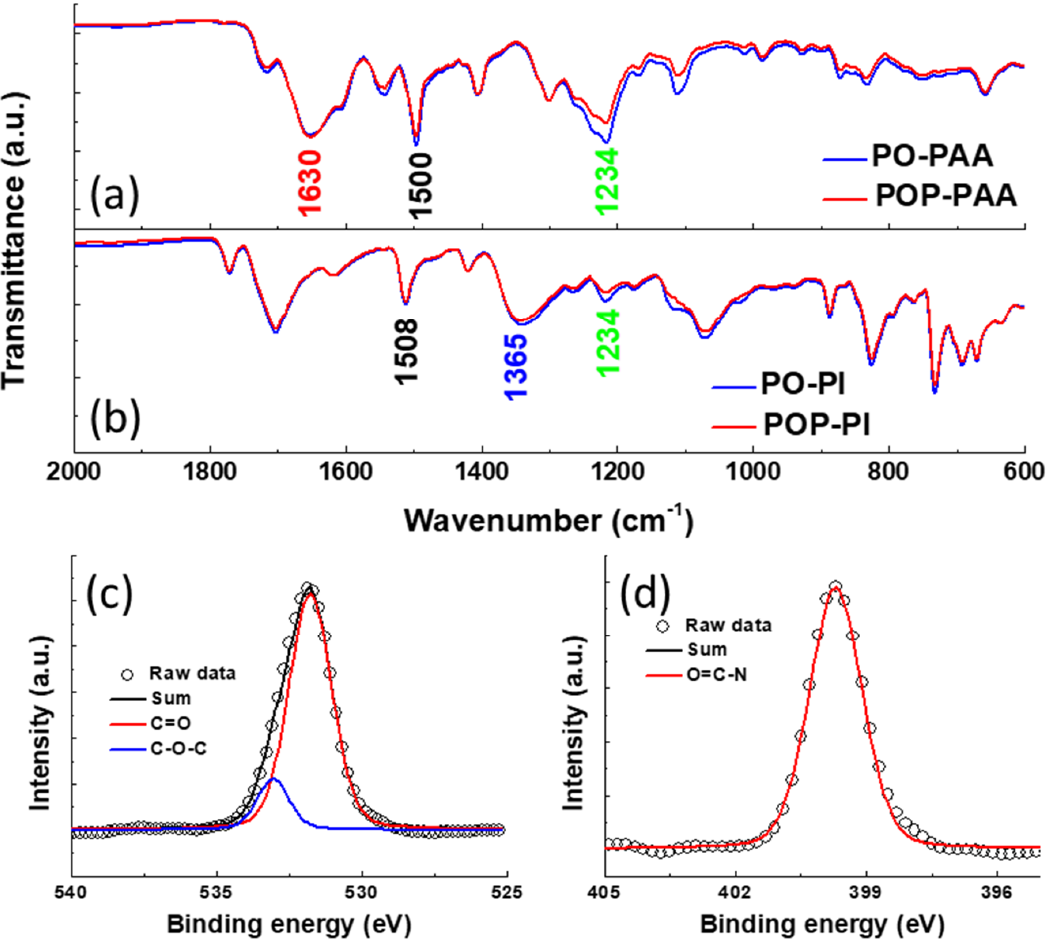
Figure 2. The Fourier transform infrared (FTIR) spectra of ( a ) PO-PAA and POP-PAA and ( b ) PO-PI and POP-PI; the peak deconvolution of the ( c ) O 1s and ( d ) N 1s X-ray photoelectron spectroscopy (XPS) spectra of the as-prepared PO-PI.